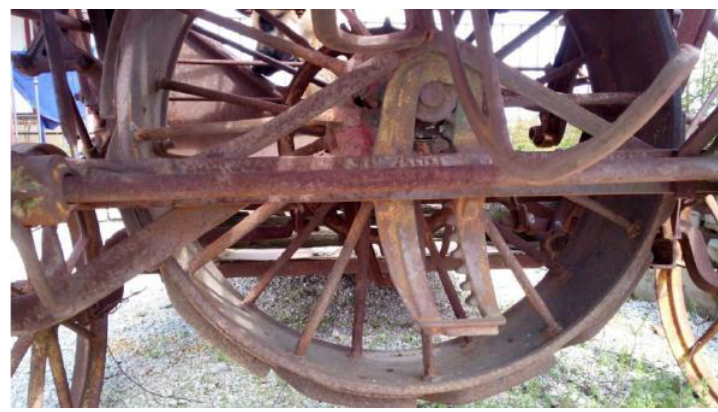
Figure 30. Drive-wheel rack.